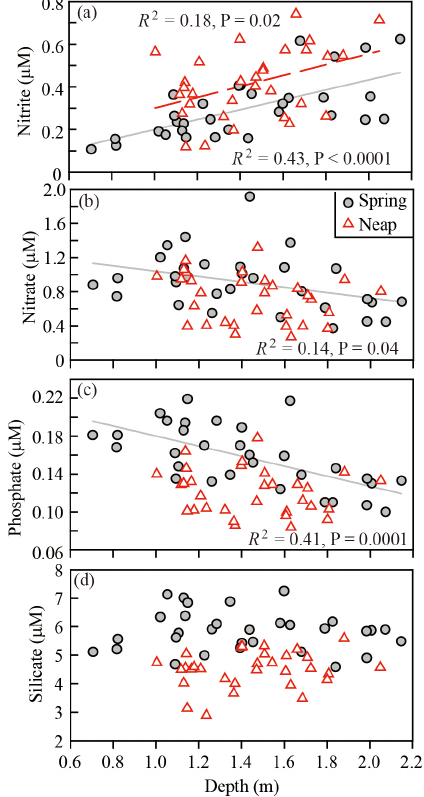
Figure 4. Concentrations of nutrients in the water column against water depth during the spring tide and neap tide at station CT in the Luhuitou reef during 6–13 February 2012. (a) Nitrite, (b) nitrate, (c) phosphate, and (d)